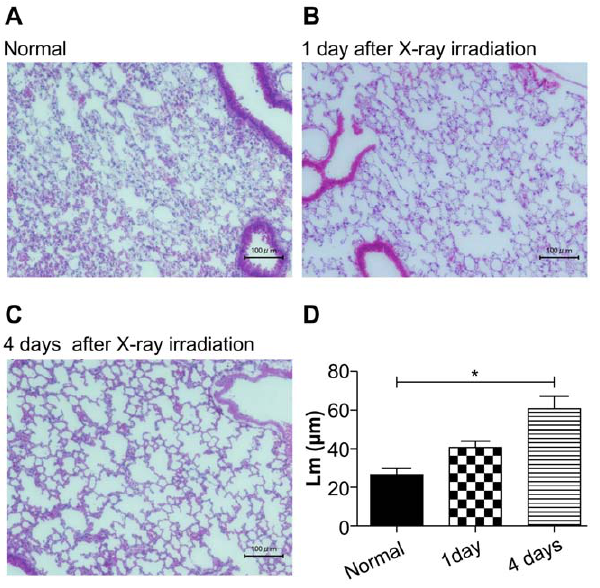
Figure 3. H & E stained histological sections of mouse lungs. Representative images of H & E stained sections of (A) normal; (B) X1, 1 day after radiation exposure; (C) X4, 4 days after radiation lungs. Scale bars represent 100 m m. (D) Comparison of mean air space (Lm values) between groups. The mean air spaces (Lm) in irradiated lungs, one and four days following irradiation, were greater than in control lungs. A significant increase was also observed between lungs four days following x-ray exposure (*; P , 0.001).